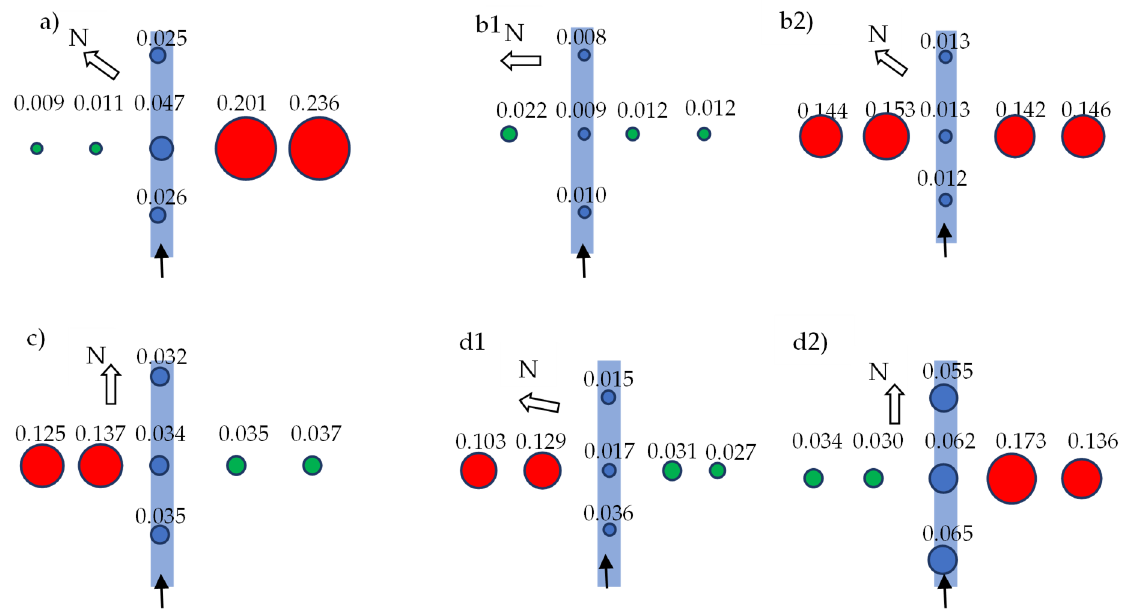
Figure 7. Concentrations of ammonium nitrogen (NH 4 -N) in the groundwater of rivers and boreholes. Blue dots refer to the surface water samples, green dots refer to the ground water samples taken in organic farming areas and red dots refer to the ground water samples taken in intensive farming areas: ( a ) Alšia, ( b1 ) and ( b2 ) Žem ė pl ė ša, ( c ) Šuoja, ( d1 ) Romatas and ( d2 ) Lomena.